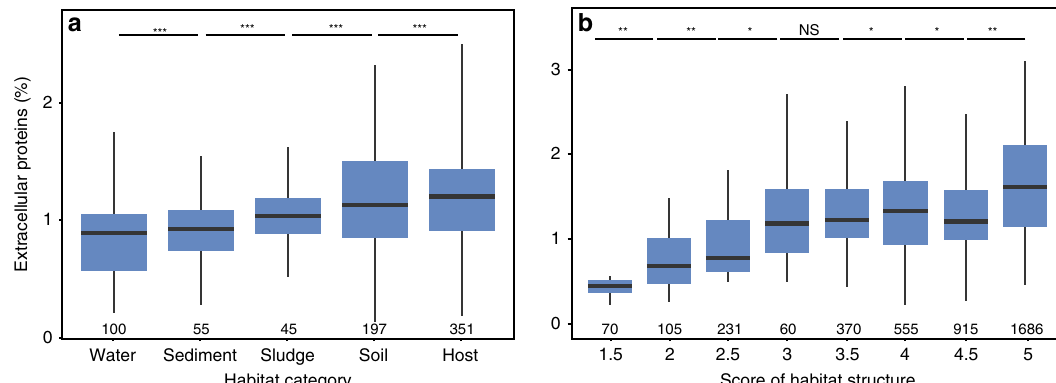
Fig. 2 Relationship between the percentage of extracellular proteins and the habitat. Boxplots represent the percentage of genes encoding extracellular proteins per genome in the different habitat categories ( a ) and in terms of habitat structure score ( b ). Boxes delimit the fi rst and third quartile and whiskers represent 1.5 times the interquartile range. a Distributions were calculated using bacteria found only in one type of habitat (to avoid counting multiple times